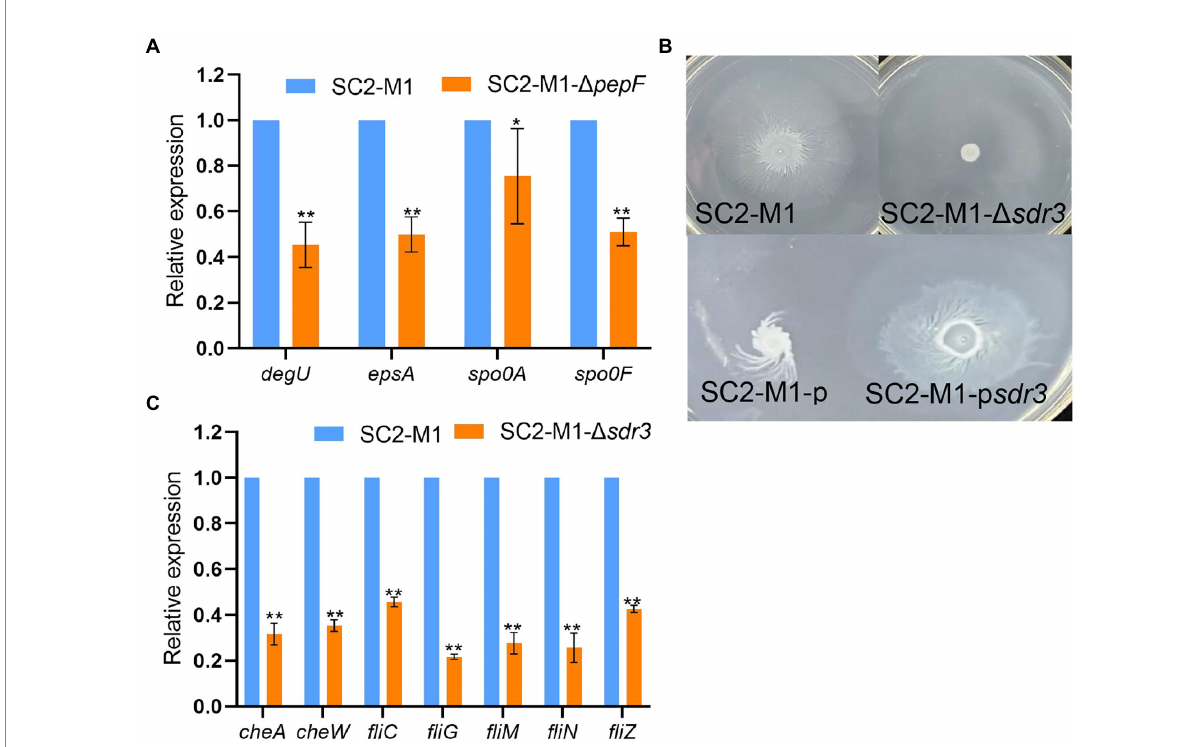
FIGURE 6 MsmR1 positively regulates motility, biofilm, and spore synthesis. (A) The expression of genes related to spore and biofilm formation in strain SC2- M1- Δ pepF and SC2-M1. (B) Motility of the SC2-M1, SC2-M1- Δ sdr3 , SC2-M1-p, and SC2-M1-p sdr3 strains in a specific plate. (C) The expression of genes related to chemotaxis and flagellum ( cheA , cheW , fliC , fliG , fliM , fliN , fliZ ) determined by qRT-PCR. * p < 0.05 and ** p <